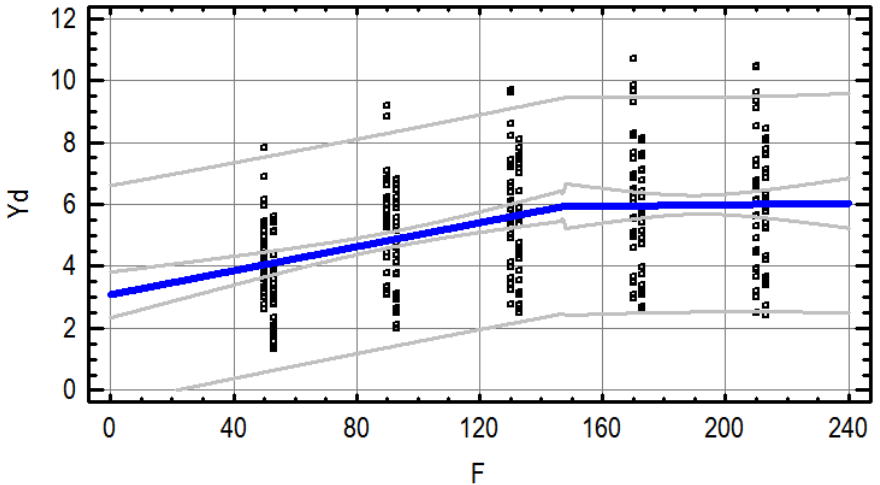
Figure 1. Observed and predicted grain yield (Yd, Mg·ha −1 ) depending on nitrogen doses (F, kg N·ha −1 ; critical F rate (C) = 149.4 kg N·ha −1 , for F < C Yd = 3.09 + 0.0194*F, R 2 = 15.3%, for F > C Yd = 5.99 Mg·ha −1 , n = 320) (blue line — estimated regression; grey lines — confidence and prediction limits at confidence level 95%).